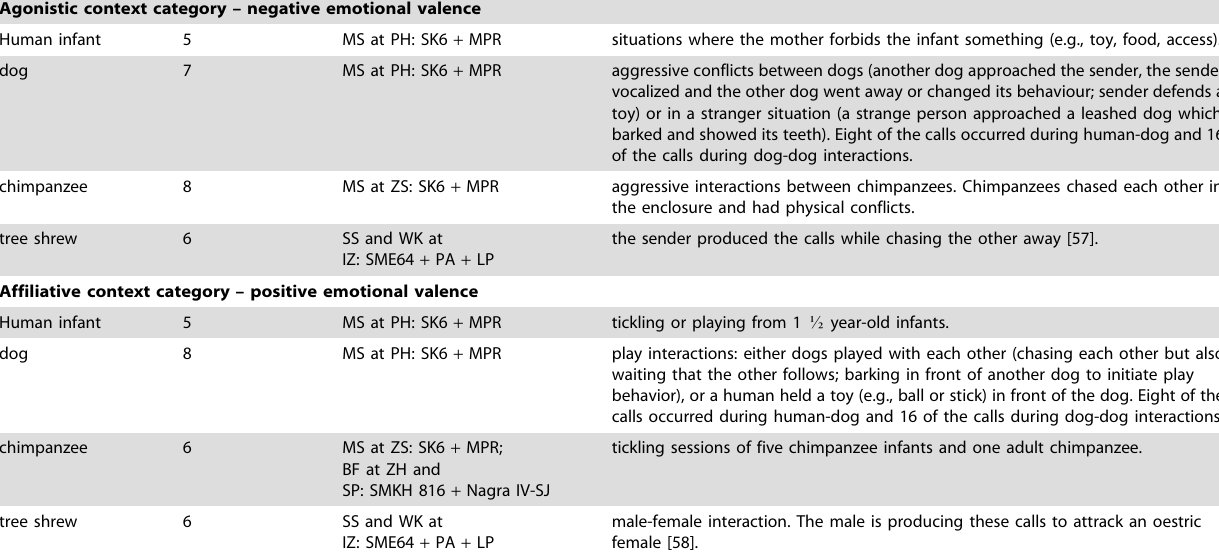
Table 1. Description of playback